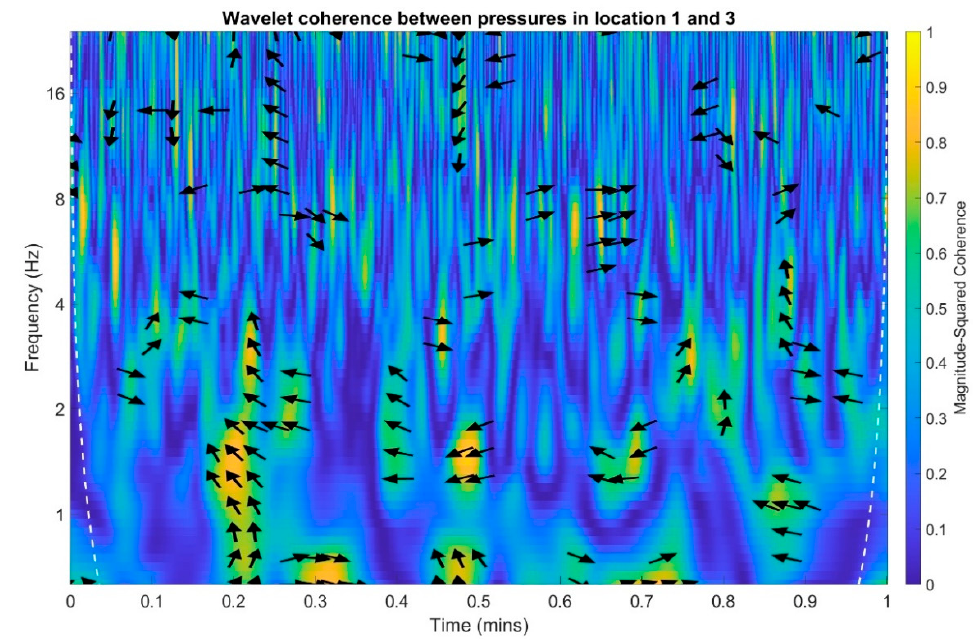
Figure 24. Wavelet coherence between acoustic pressures of infrasound measured in locations 1 and 3.